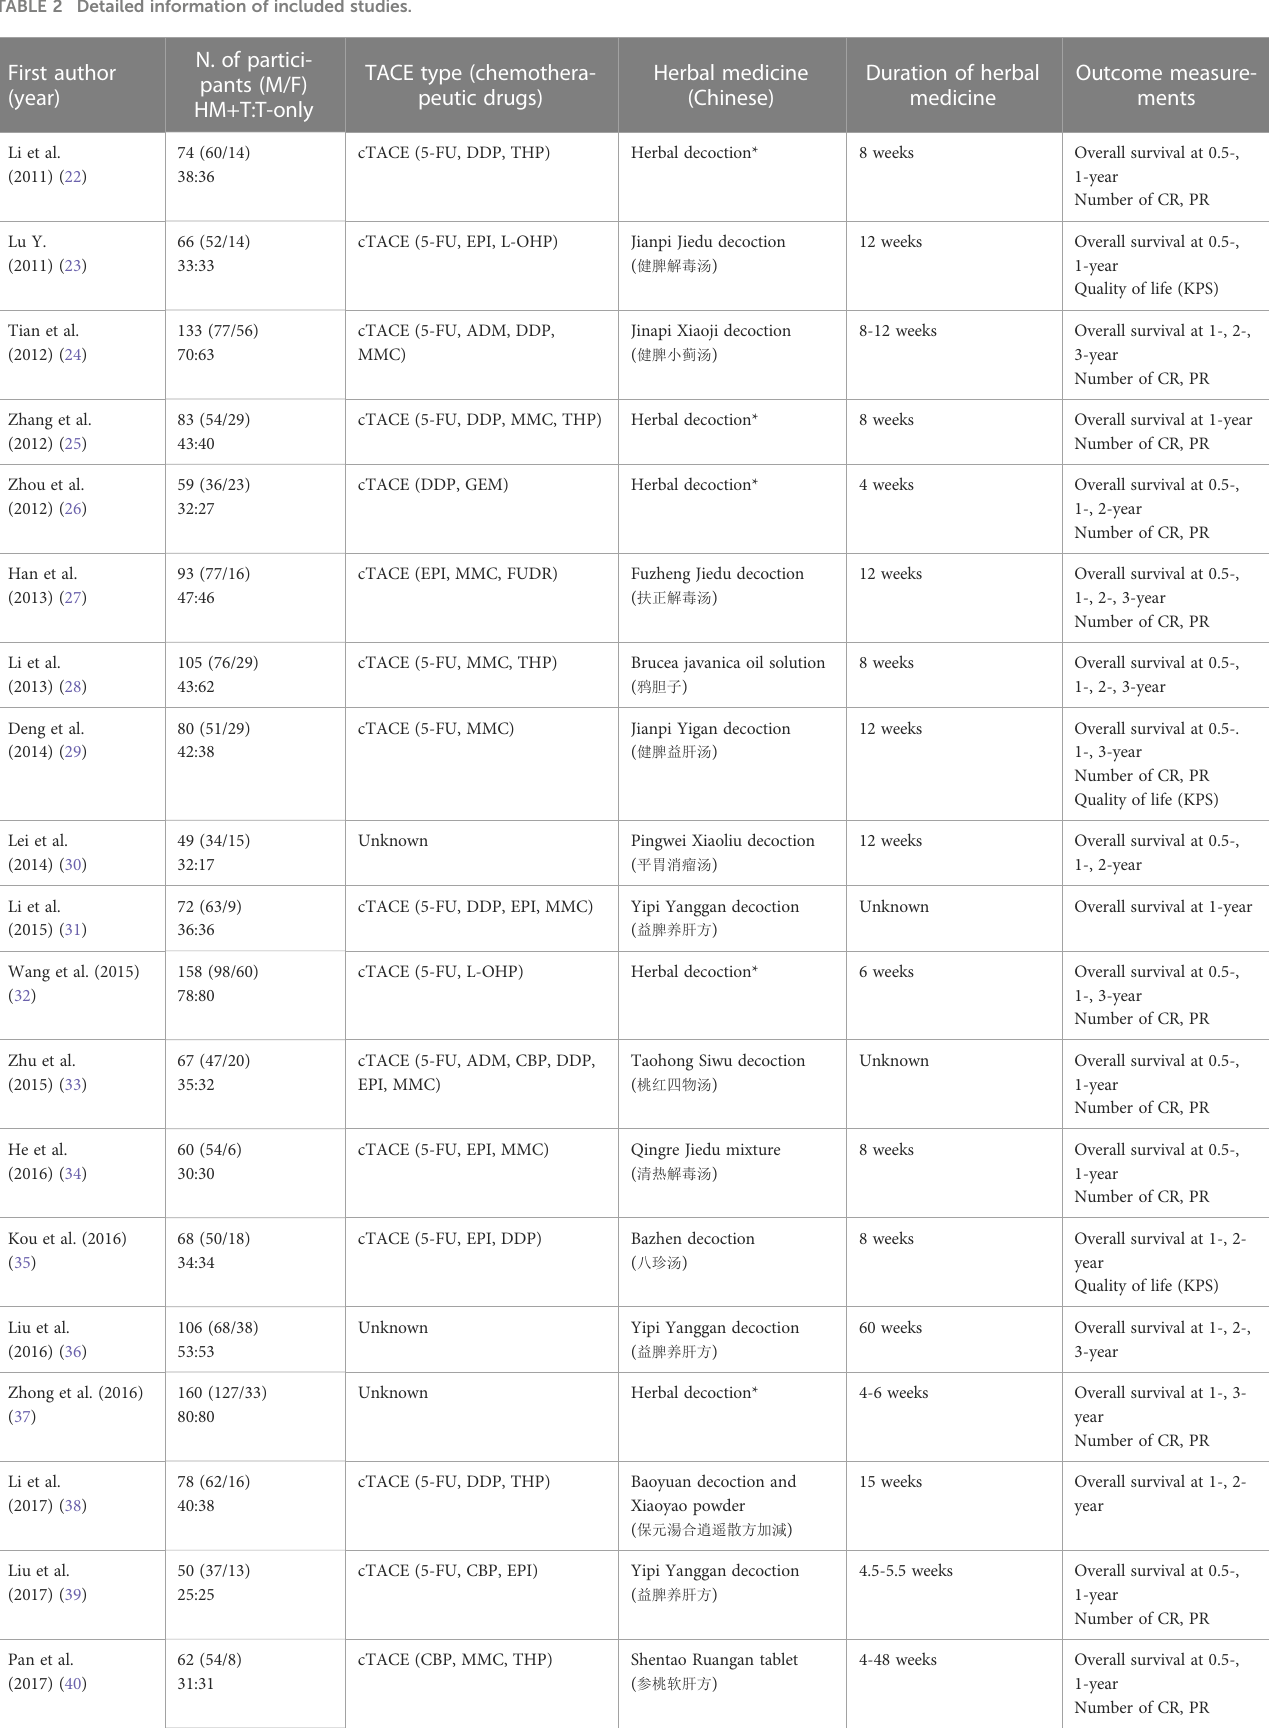
TABLE 2 Detailed information of included